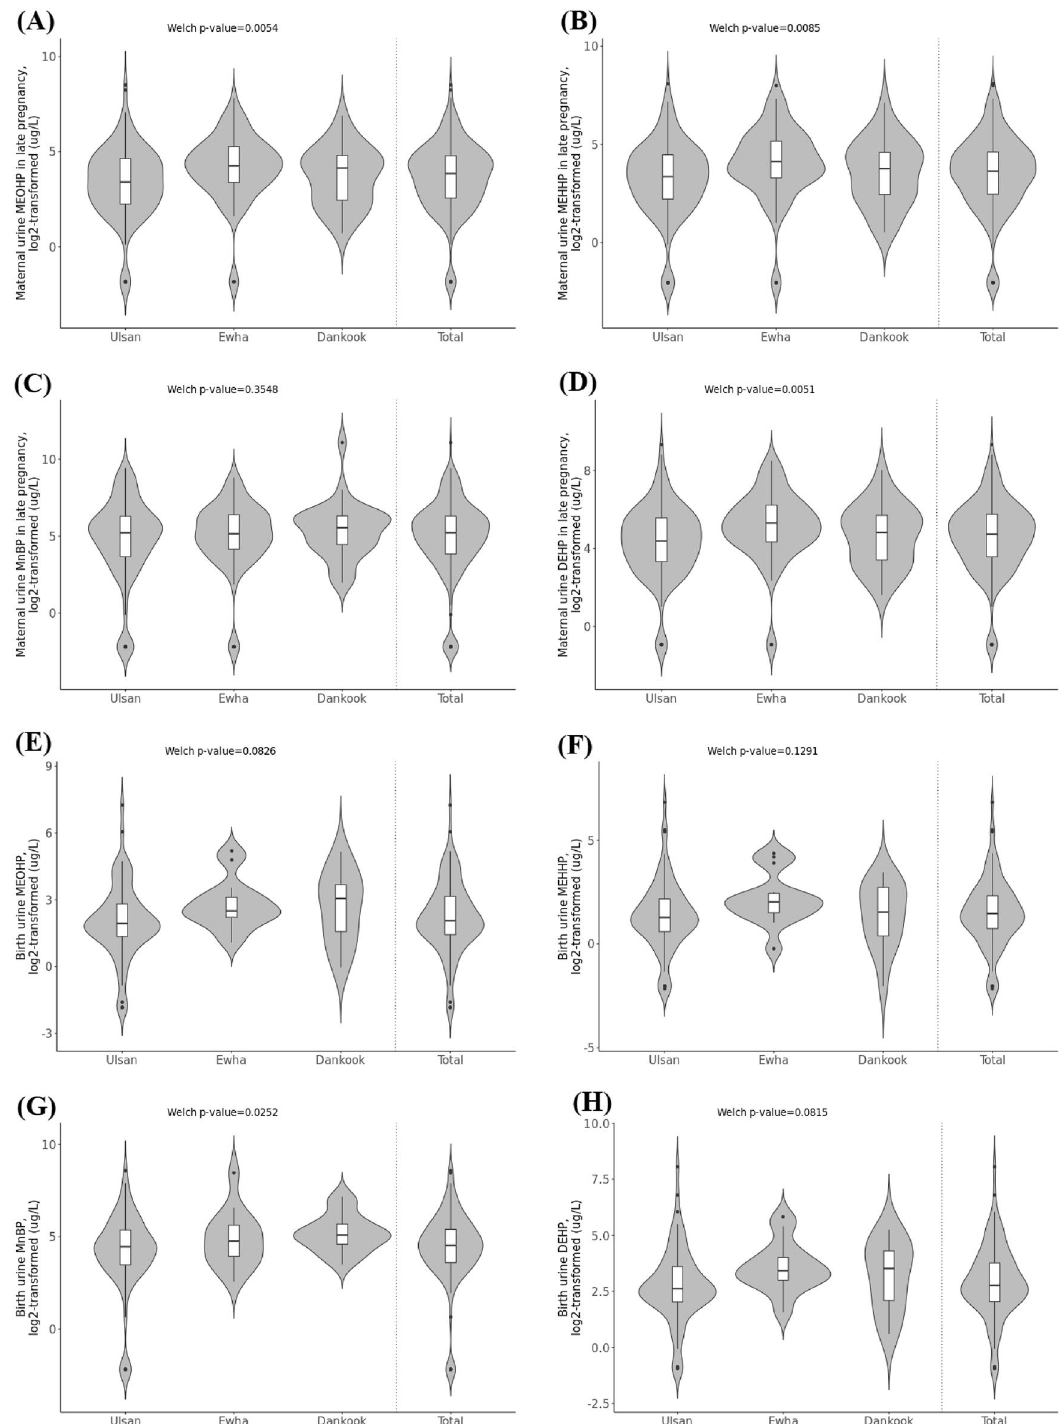
Figure 1. Violin plots of log 2 -transformed ( A ) maternal urine MEOHP concentrations during late pregnancy, ( B ) birth urine MEOHP concentrations, ( C ) maternal urine MEHHP concentrations during late pregnancy, ( D ) birth urine MEHHP concentrations, ( E ) maternal urine MnBP concentrations during late pregnancy, ( F ) birth urine MnBP concentrations, ( G ) maternal urine DEHP concentrations during late pregnancy, ( H ) birth urine DEHP concentrations. Plots for each of the three centers, namely, Ulsan, Ewha, and Dankook, and for the total samples are shown; p -values of Welch’s one-way test on the phthalate concentrations for the three centers are